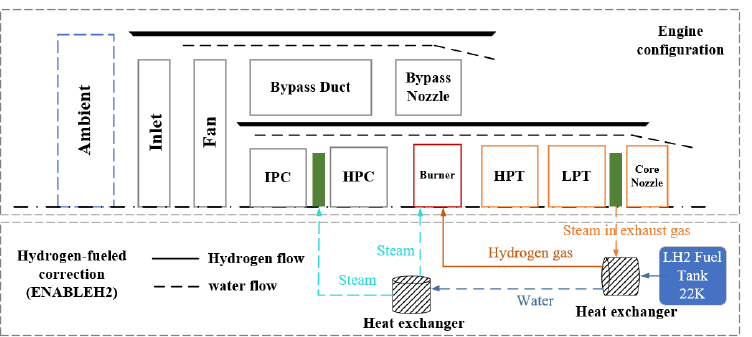
Figure 2. Configuration of hydrogen-fueled turbofan engine proposed by P&W’s HySIITE project